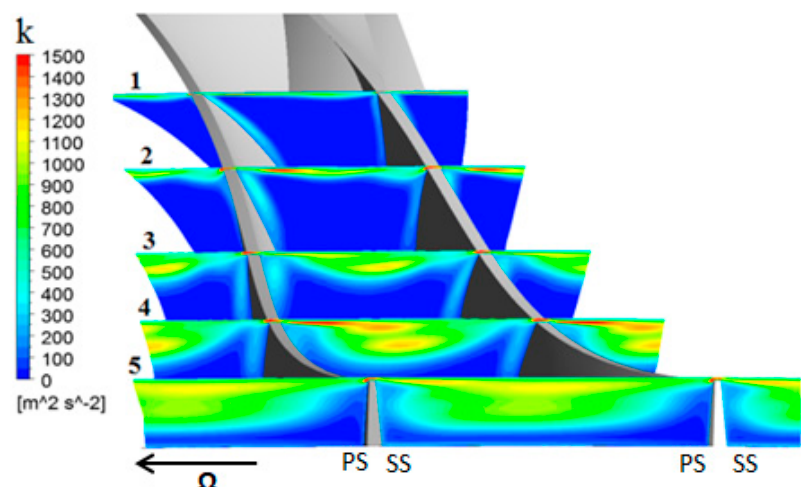
Figure 10. Turbulence kinetic energy in the impeller, point P1.